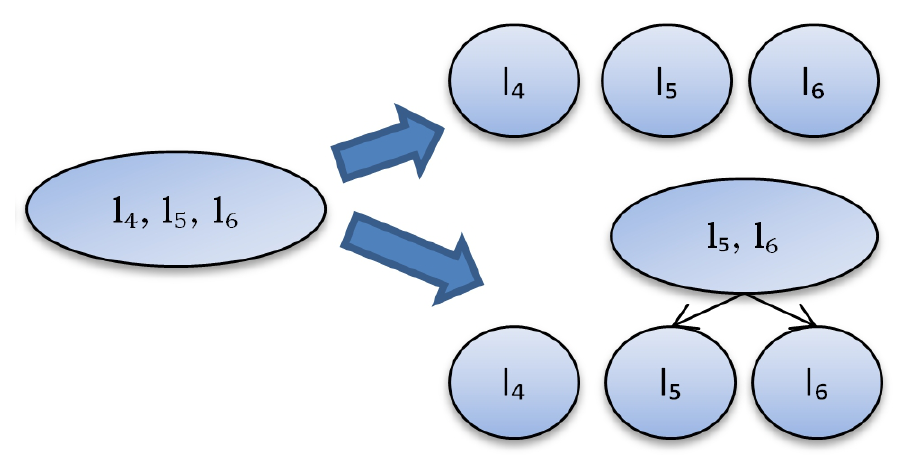
Figure 4. Different ways of splitting the